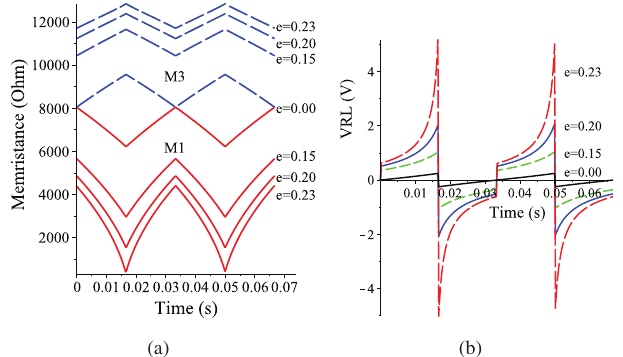
Fig. 7 : System supplied by a periodic square wave voltage source with V 0 = 10 V , f = 30 Hz , x 1 ( 0 ) = x 4 ( 0 ) = 0 . 5 + e , x 2 ( 0 ) = x 3 ( 0 ) = 0 . 5 − e . (a) M 1 ( x ) and M 3 ( x ) as a function of t for different initial conditions, (b) V RL dependent on t for different initial conditions.